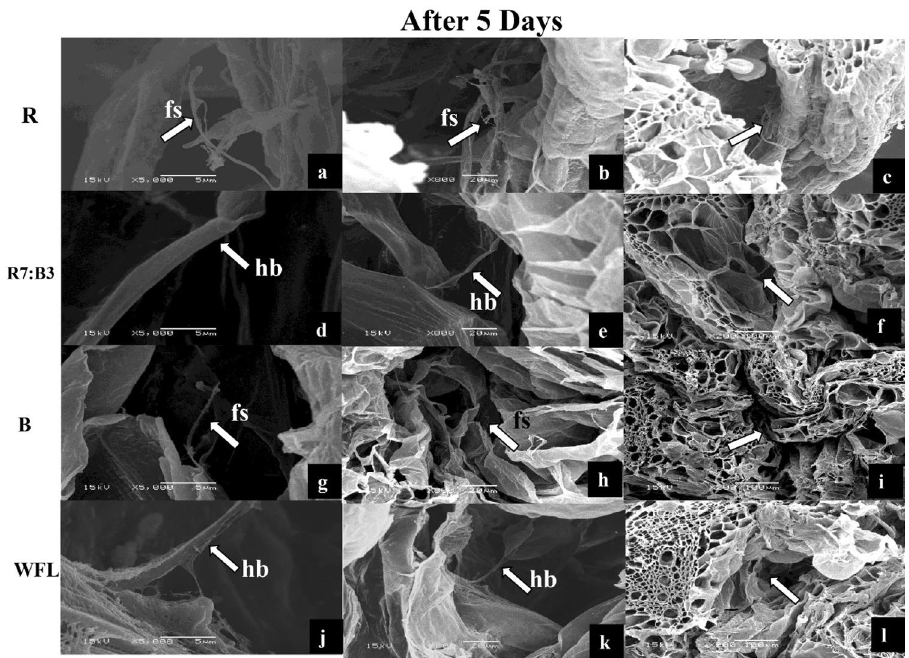
Figure 3. SEM images of interconnections between rootstock and scion after 5 days under R light ( a – c ), R7:B3 light ( d – f ), B light ( g – i ), and WFL light ( j – l ) light at the 5th days after grafting. fs—filamentous structures; hb— horizontal